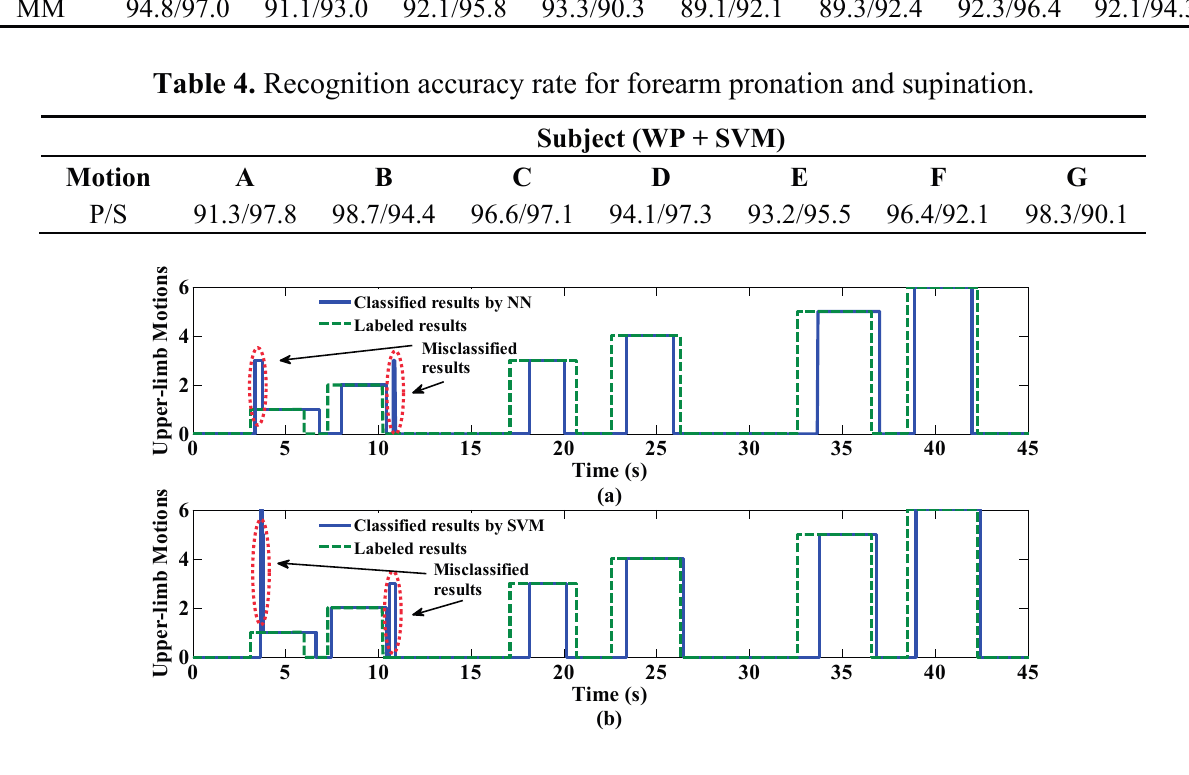
Figure 3. On-line testing performance with MM feature extraction method. ( a ) shows the classification results by NN; ( b ) shows the classified results by SVM. The red circles mark the misclassifications using the two